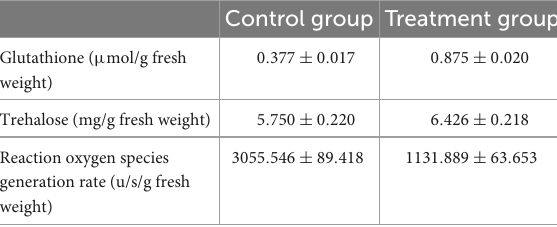
TABLE 2 Contents of glutathione, trehalose, and reactive oxygen species in Penicillium olsonii WHG5. Control group Treatment